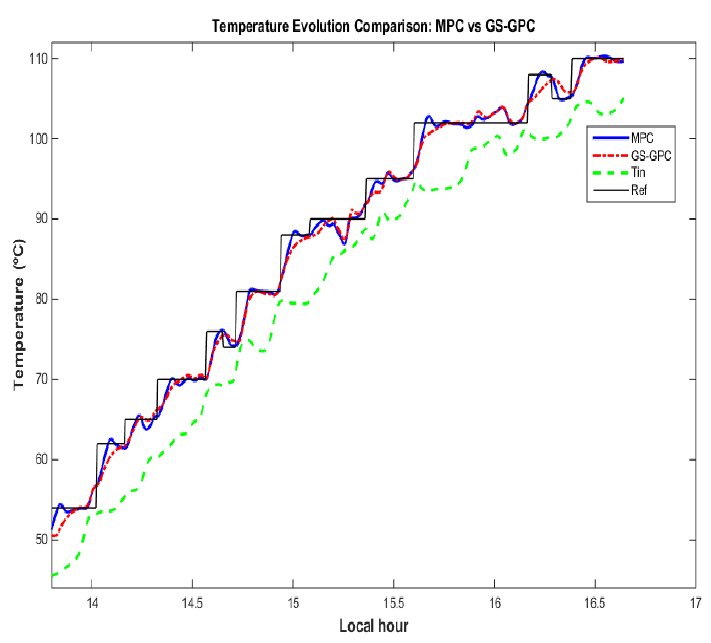
Figure 14. Simulation 2: Tracking references in recirculation mode.